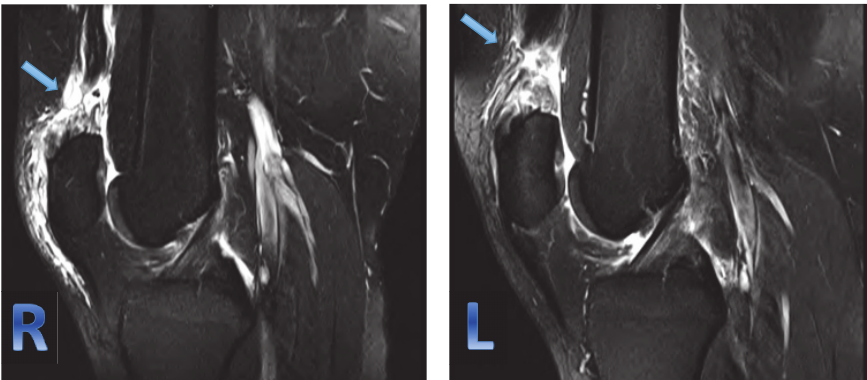
Figure 1: MRI of right and left knees showing T2-weighted sagittal image and demonstrating a full-thickness tear of the quadriceps tendon at the osteotendinous junction and fluid within the tendon gap with some retraction of the tendon which is more pronounced on the left side.